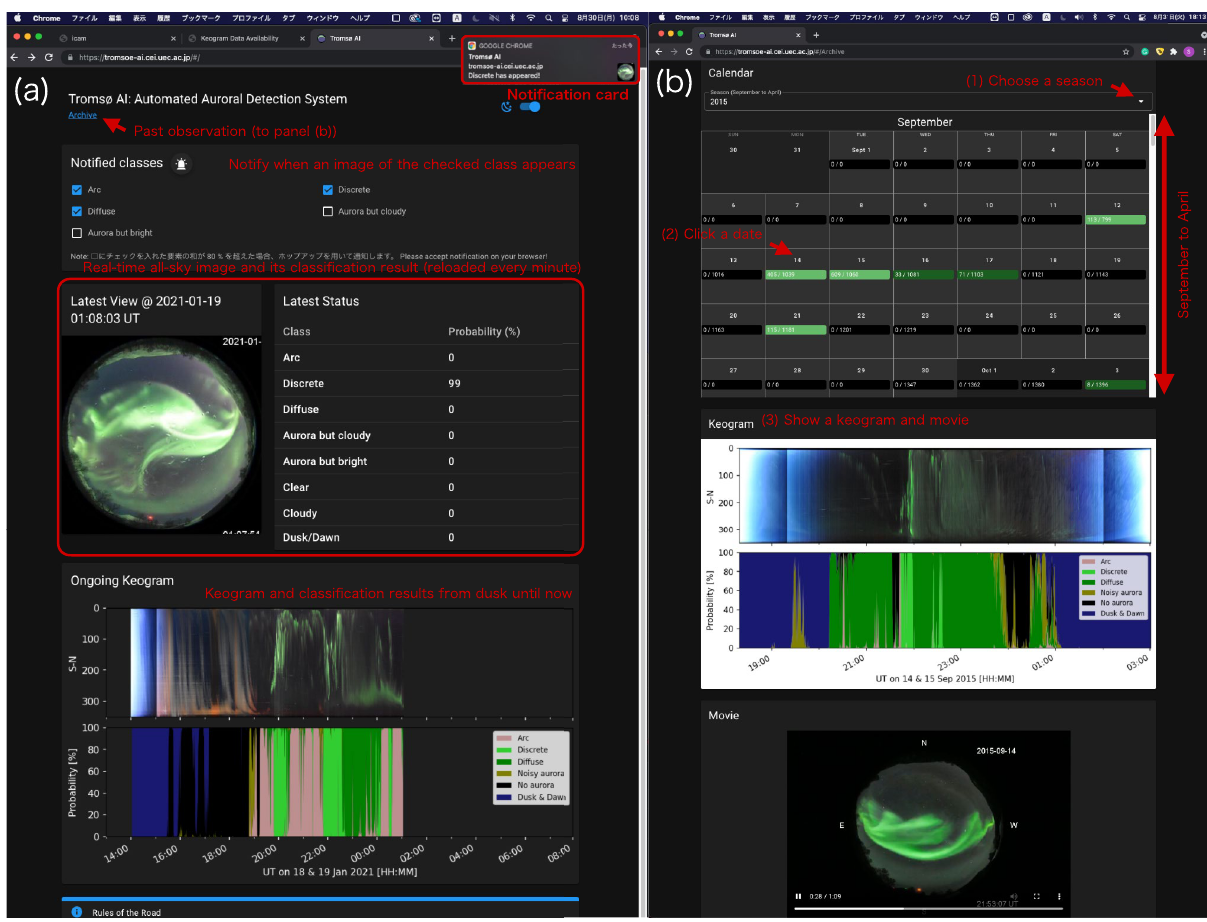
Figure 8. ( a ) Top page of Tromsø AI. In the central part, the all-sky image and the classification result are displayed in real-time. In the lower part, the ongoing keogram from the sunset is displayed in the same format as Fig. 3. A desktop notification appears in the upper right when an image of the classes checked in “Notified Classes” is displayed. Clicking on “Archive” below the page title trans the archive page shown in panel ( b ). ( b ) A user can view a keogram and all-sky movie on any day by selecting a season from the drop-down menu and clicking on a date in the displayed ongoing keogram in the same format as that in Fig. 3, showing the auroral activity up to that time of the night. In addition, a user can browse all observation results for the last ten years by clicking on the “Archive” link at the bottom of the title. Panel (b) shows the page for the archived data. A user can select a season from the pull-down tab to view the calendar for the corresponding period (from September to April). Clicking on a date in the cal- endar will display the keogram and movie for that night. Each date in the calendar has a fraction, the numerator of which is the number of images classified as Auroral classes and the denominator is the total number of images obtained that night. Days with a high number of Auroral images are shown in green color on the calendar.